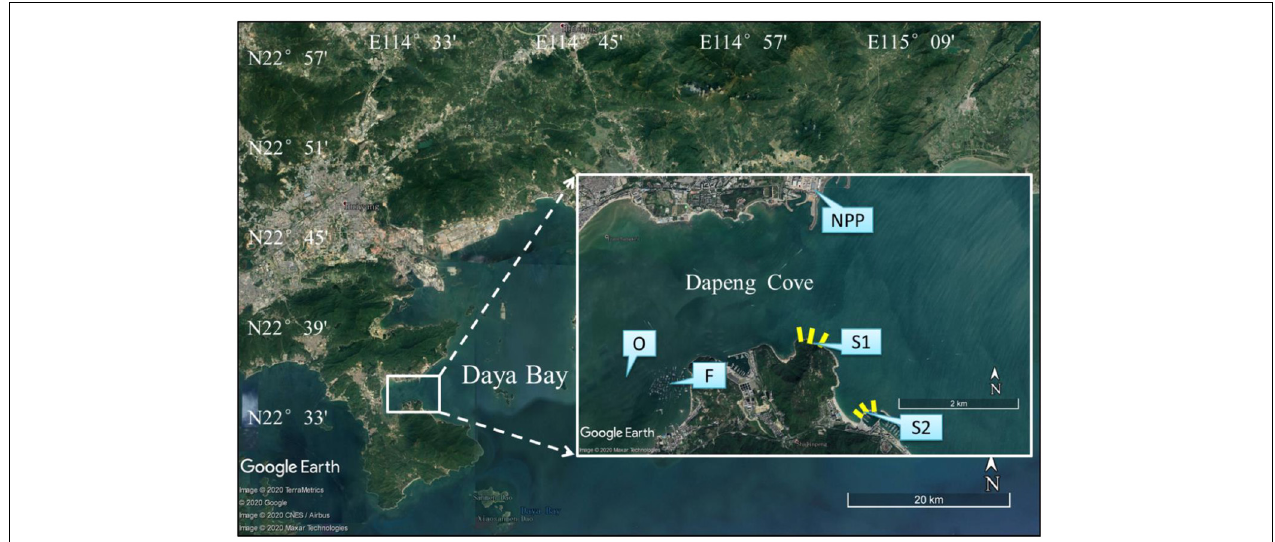
FIGURE 1 | Map of study sites, with inset depicting the open area (S1) at the mouth of Dapeng Cove, and S2, the protected area in open water; yellow bars indicate transect lines. NPP, nuclear power plants; O, oyster farm; F, fish farm.